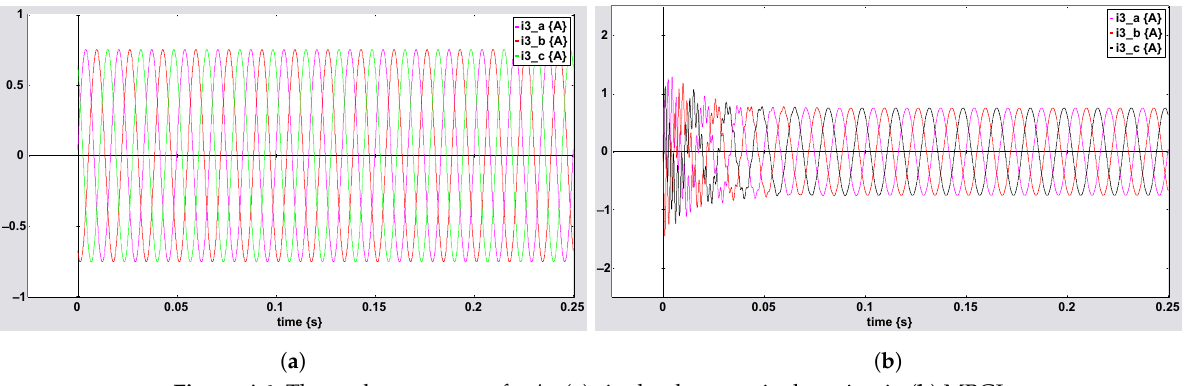
The graphical behavior of the three-phase currents for i 3 is shown in Figure A6a,b, illustrating i 3 from the MBGI of Figure 12.